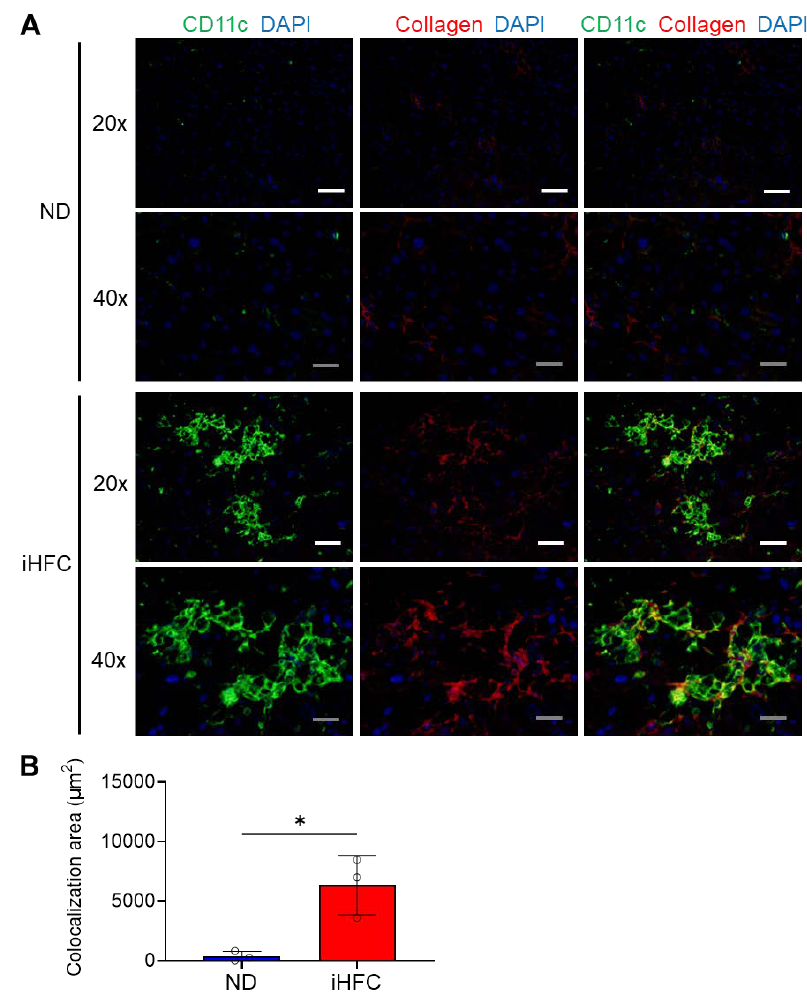
Figure 6. The iHFC diet accumulates CD11c + cells which are colocalized with collagen fibers. ( A ) Representative histological images ( 20× or 40× magnification) of fluorescent immunohistochemistry for CD11c, collagen type 1, and DAPI of the livers from TSNO mice on the ND or iHFC diet for 12 weeks. White scale bars, 100 µ m. Gray scale bars, 50 µ m. ( B ) Colocalization areas were calculated as described in Figure S10 and the Materials and Methods. Data are shown as means ± SD. * p < 0.05. Statistical significance was evaluated by unpaired Student’s t